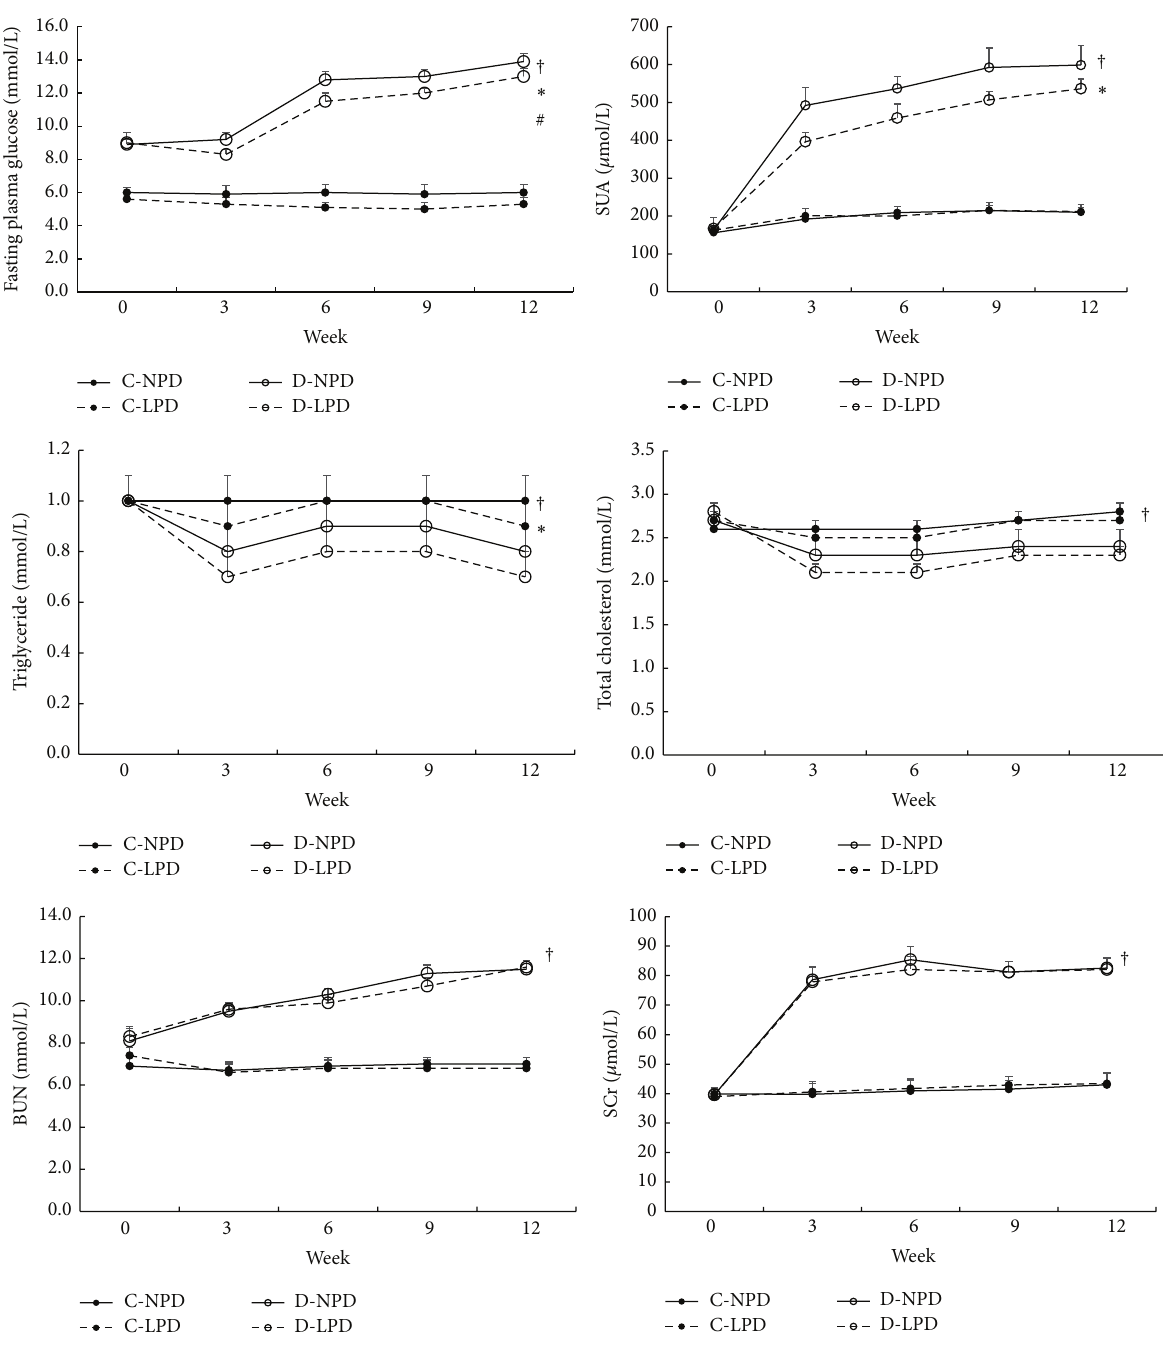
Figure 3: Time course of blood biochemical indexes among different rat groups. Solid circle with solid and dashed lines represents C-NPD and C-LPD group, respectively, while hollow circle with solid and dashed lines shows data of D-NPD and D-LPD group, respectively. Data were expressed as mean ± SD. † 𝑃 < 0.05 for D-LPD versus C-NPD rats, ∗ 𝑃 < 0.05 for D-NPD versus D-LPD group, and # 𝑃 < 0.05 for C-NPD versus C-LPD group in the global trend comparisons. SUA: serum uric acid, BUN: blood urea nitrogen, SCr: serum